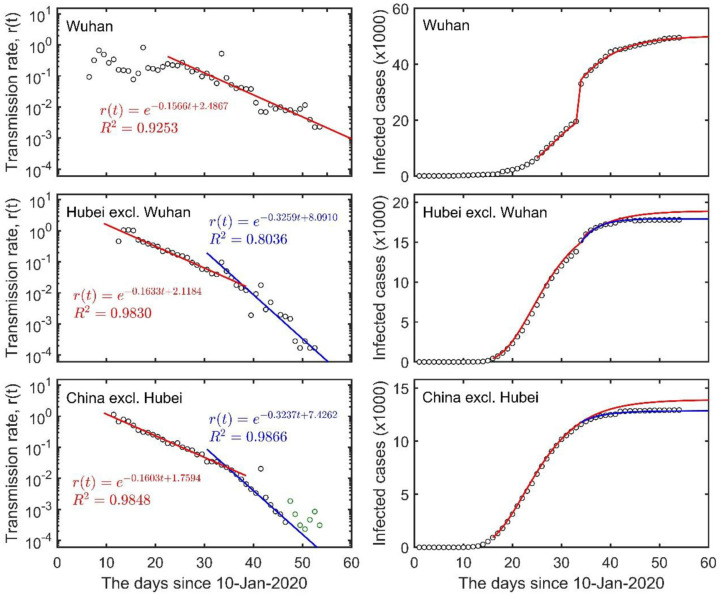
The exponential damping of COVID-19 transmission rates in Wuhan city, Hubei Province (excluding Wuhan) and the rest of Chinese mainland (excluding Hubei) (left column), and the total number of infection cases (right column). The red and blue lines on the left panels represent regressions of the data, and the lines on the right panels are the corresponding predictions using the fitted time-dependent transmission rate [r (t)]. Circles indicate real data, and green circles indicate cases imported from other countries but were not considered in the regression.